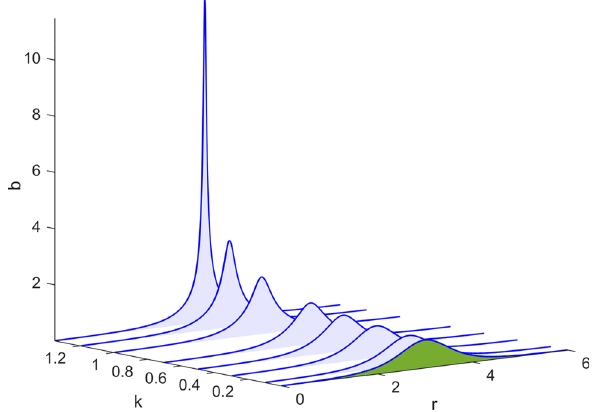
Fig. 2 Evolution of the solution for the longitudinal electromagnetic field with a change in the parameter k in Born–Infeld